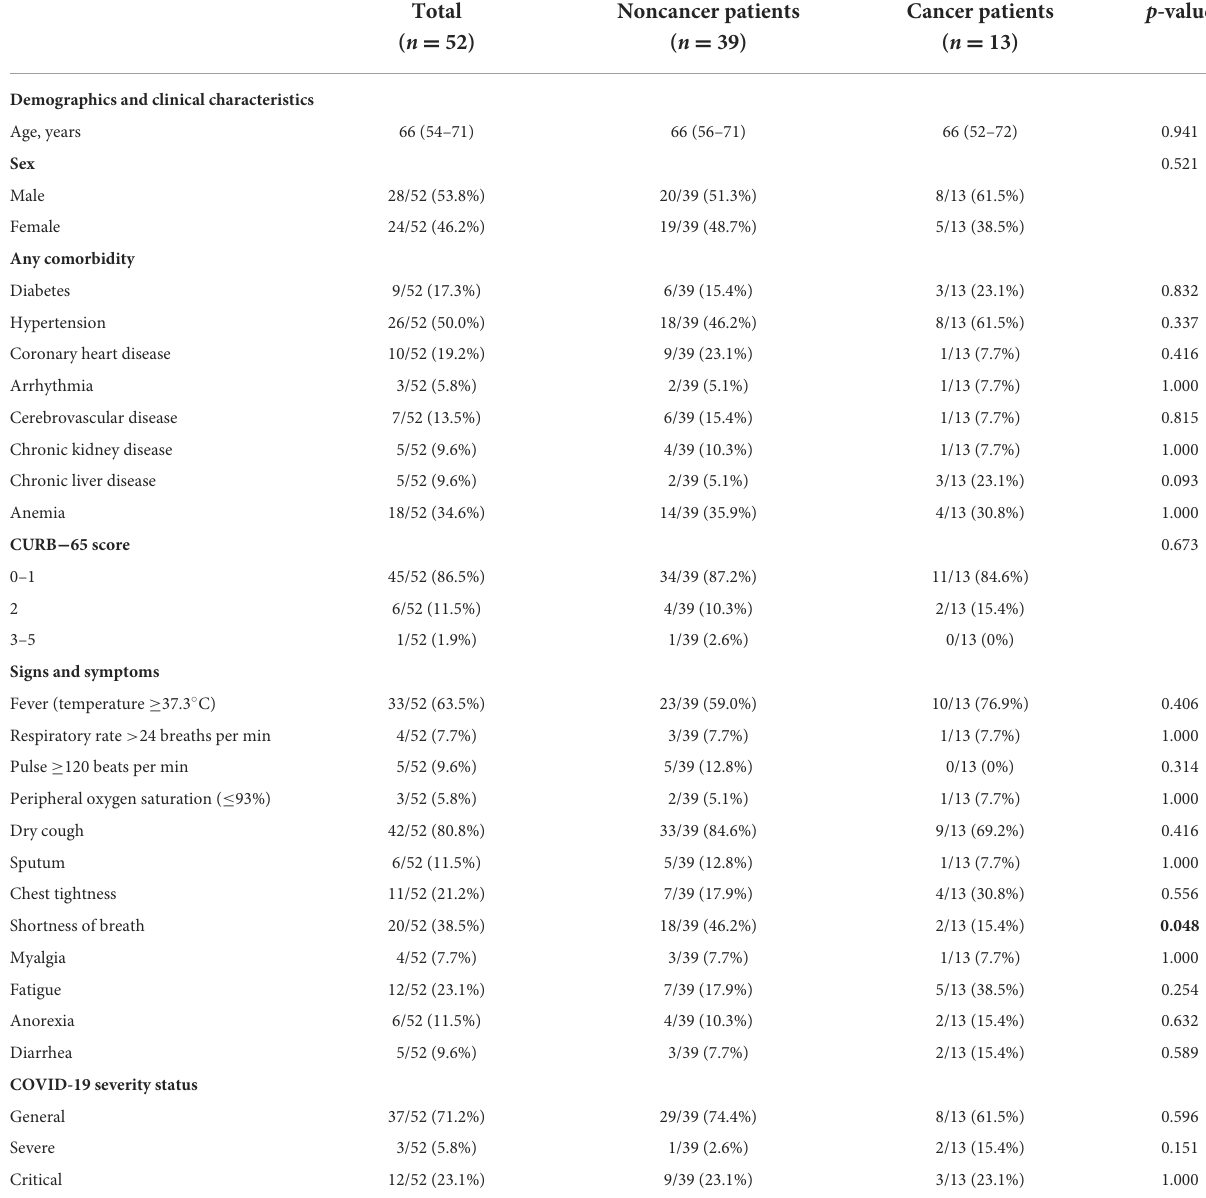
TABLE 2 Demographics and baseline characteristics of COVID-19 patients with and without cancer.